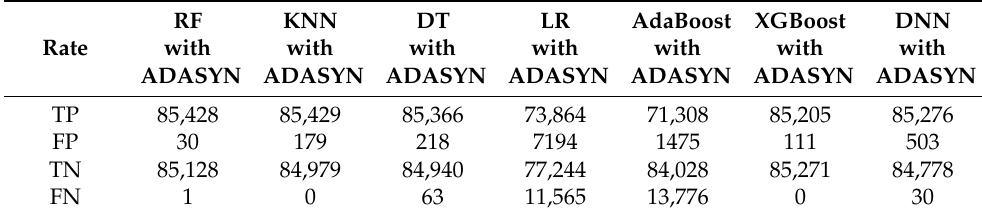
Table 8. TP, FP, TN, FN rates of machine learning algorithms with ADASYN based on resampling approach